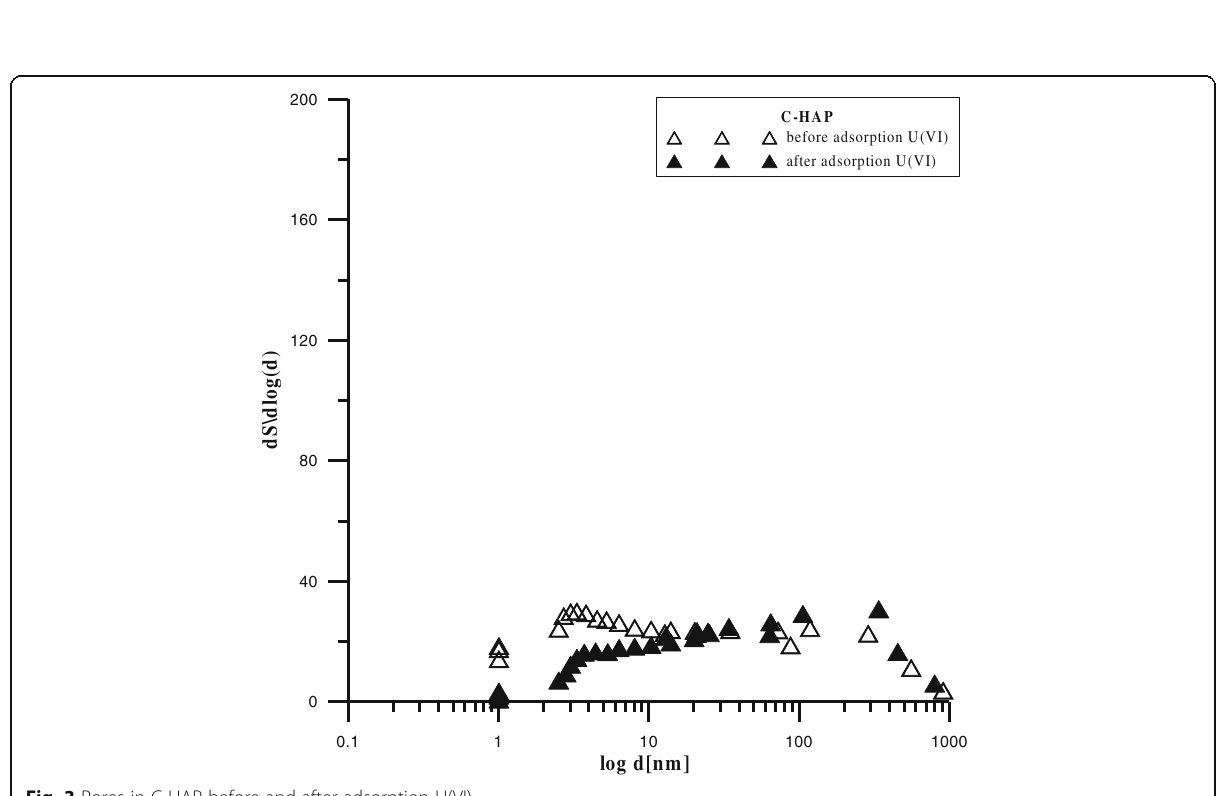
Fig. 3 Pores in C-HAP before and after adsorption